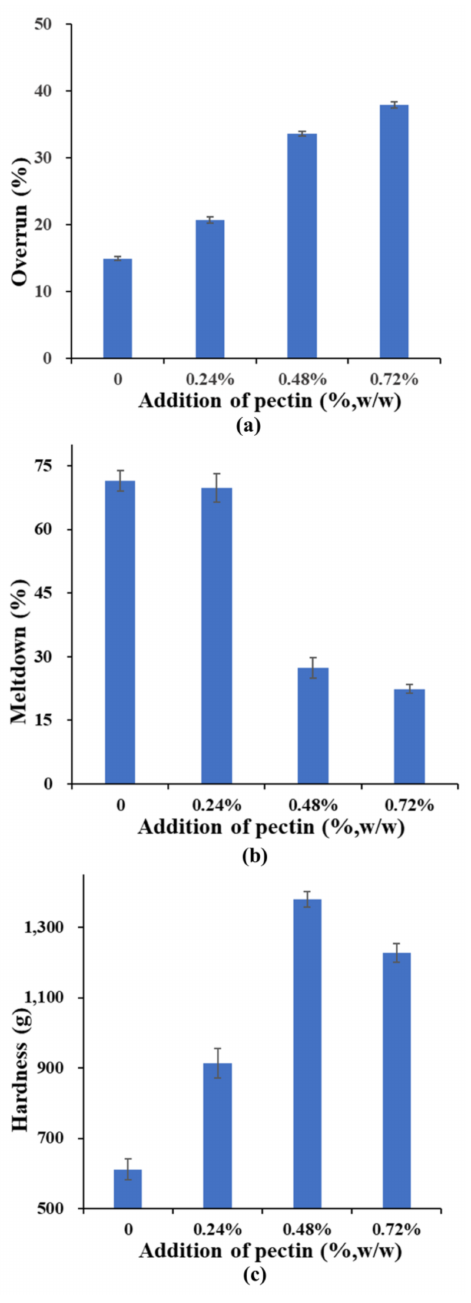
Figure 3. The influence of pectin addition on the ( a ) overrun, ( b ) meltdown and ( c ) hardness of ice